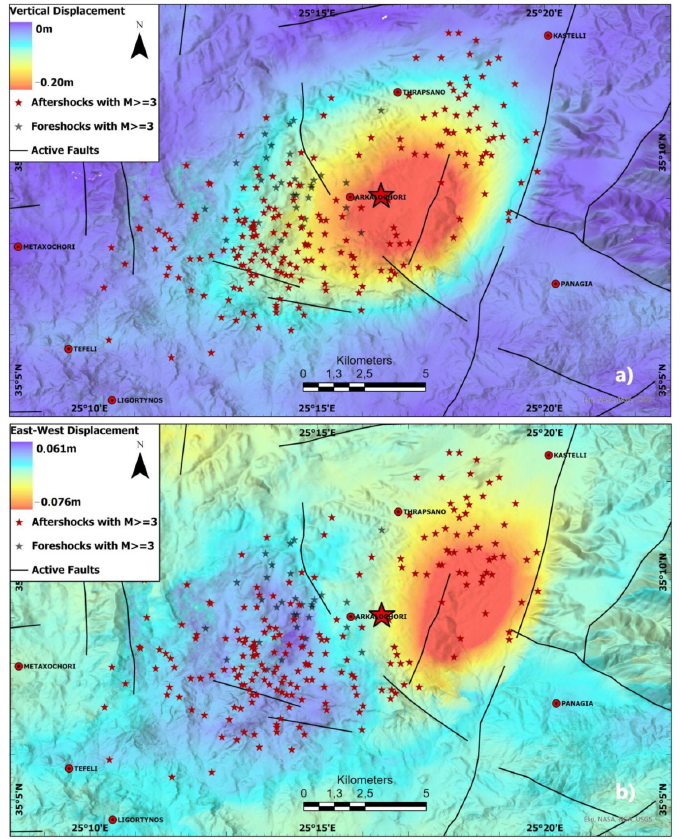
Figure 11. Displacement maps for ( a ) the vertical (up–down) and ( b ) the E–W displacement components for the Arkalochori earthquake overlain by the earthquakes with magnitude greater than 3 and the active faults of the broader area. Positive values on the E–W component indicate eastward motion, while the negative ones describe westward motion.